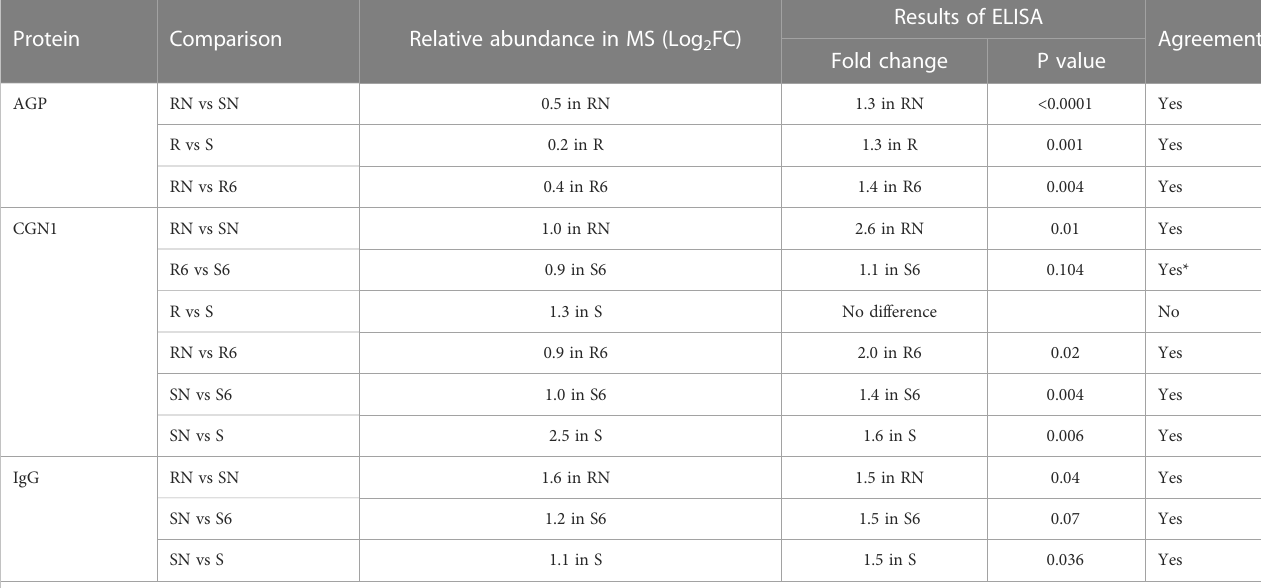
CGN1 was not signi fi cantly different between resistant and susceptible groups at 6hr and 105d PFI timepoints, which contrasted with the MS fi ndings. When compared to the baseline samples, concentrations of AGP (1.4-fold; P = 0.004) and CGN1(2.0-